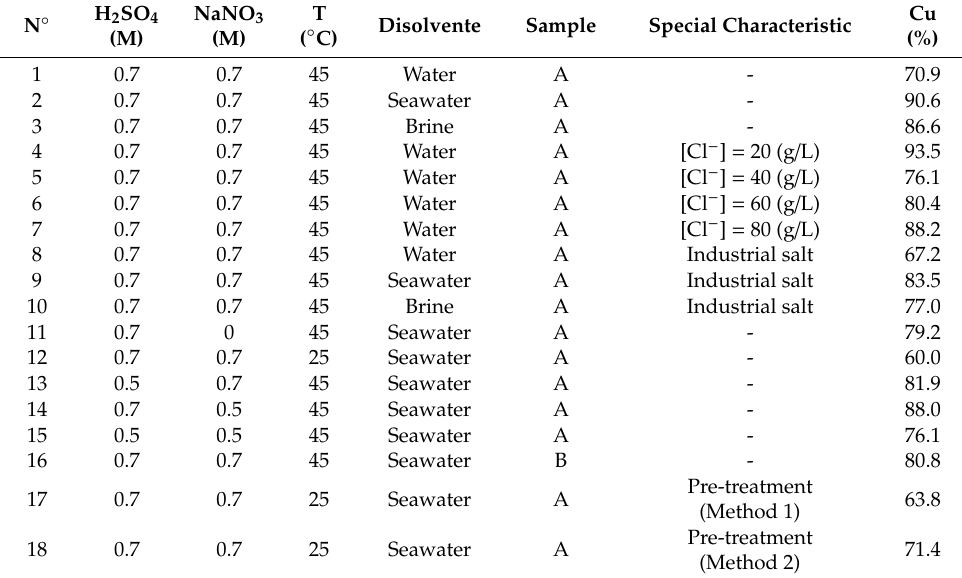
Table 3. Leaching tests carried out with concentrate